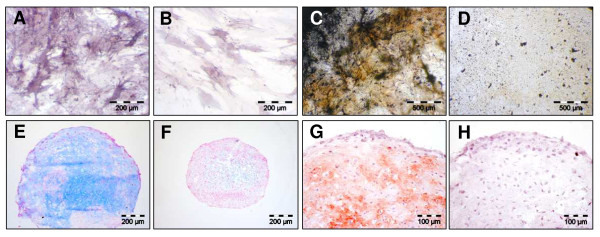
Osteogenic and chondrogenic differentiation of human MSC (A-H). On day 21, alkaline phosphatase staining of osteogenically induced MSC cultures demonstrated an enhanced AP activity (A) when compared to control cultures (B). On this day, von Kossa staining of osteogenically induced cultures was positive indicating a formation of mineralized bone matrix (C), whereas control cultures stained negative (D). TGFβ3 - induction of chondrogenesis, on day 21, resulted in the secretion of cartilage proteoglycans as shown by alcian blue staining (E), and of cartilage specific collagen type II (G). Control cultures showed no secretion of both extracellular matrix molecules (F, H).